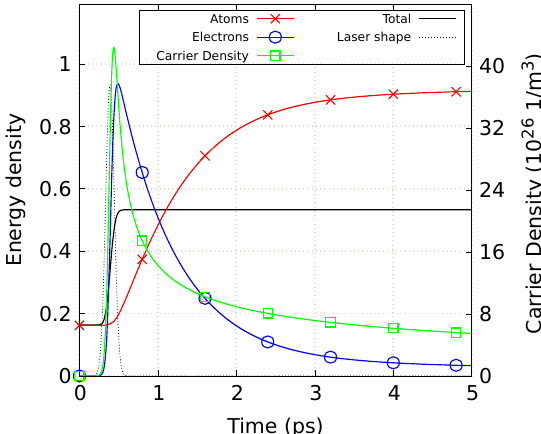
Figure 2. Electron/lattice energy densities (divided by the melting energy density) and carrier density dynamics, according to the n TTM model, at the surface of silicon target of 800nm width, followed by the 130fs laser pulse at the incident fluence of 0.26J/cm 2 . The total energy density, averaged through the whole sample, is shown with black solid line. The laser pulse shape, shown with black dotted line, is not in